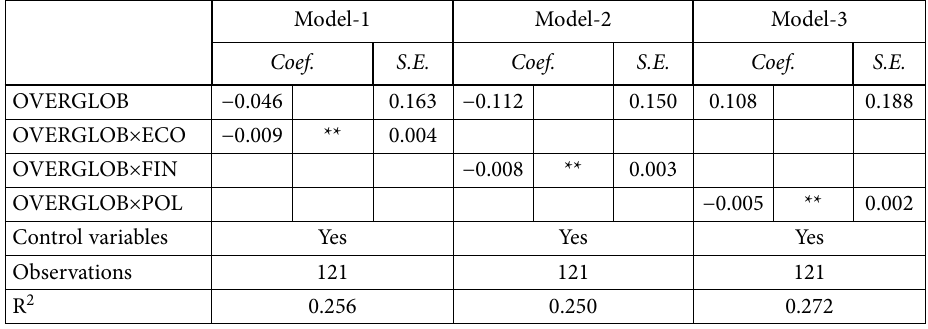
Table A8. The effects of globalization under different country risks (cross-sectional